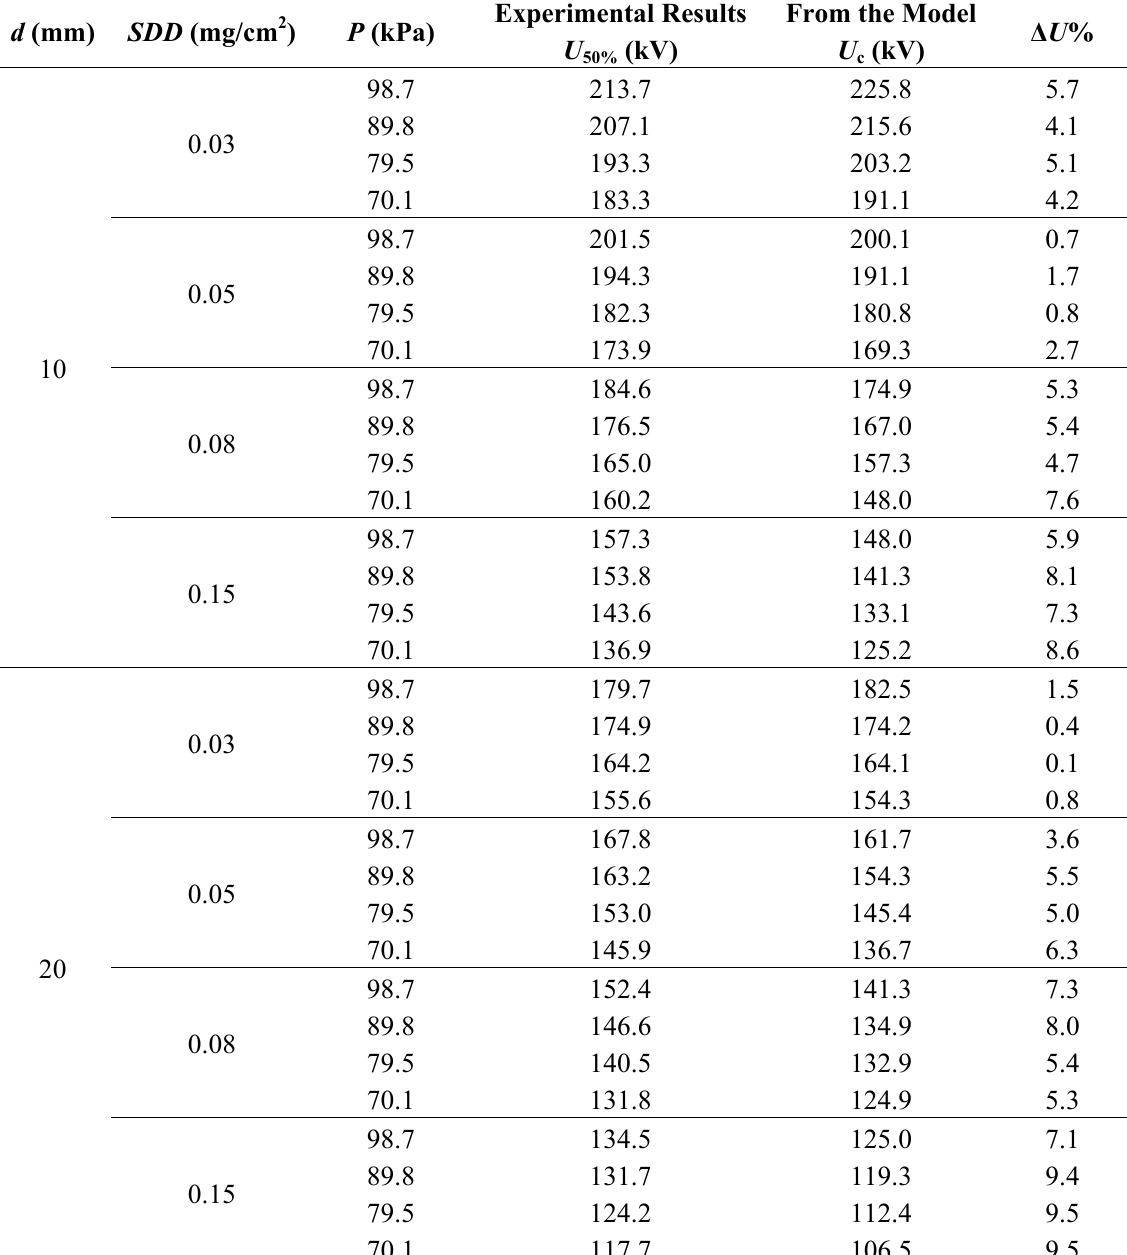
Table 4. Test and calculation results of the DC flashover voltage of the ice-covered 15-unit XZP-210 insulator